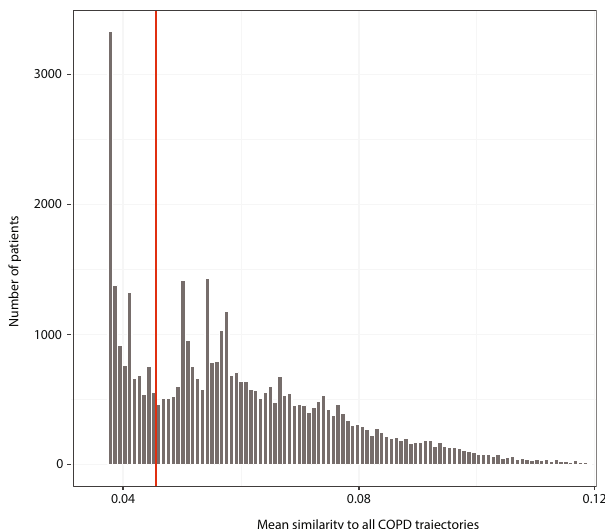
Fig. 2 Mean similarity of patient histories of non-followers and chronic obstructive pulmonary disease (COPD) trajectories. The overall mean similarity of all the 42,459 non-followers COPD patients to all COPD trajectories. The 10,974 non-followers have a mean similarity score below 0.046, thus they are the most dissimilar COPD patients.